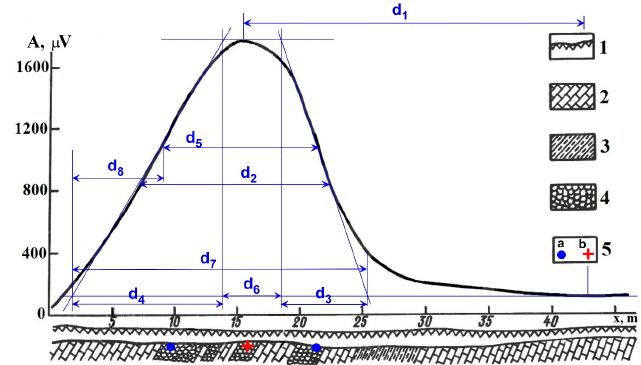
Figure 3. Quantitative analysis of piezoelectric measurements at a gold-bearing quartz deposit Ustnerinskoe (Yakutia region, Russia) (initial geological-geophysical data from [14]): (1) deluvium; (2) limestone; (3) quartz-mica shales; (4) veined quartz; and (5) obtained parameters for the model of thick bed: (a) angle points; and (b) center of the anomalous body.